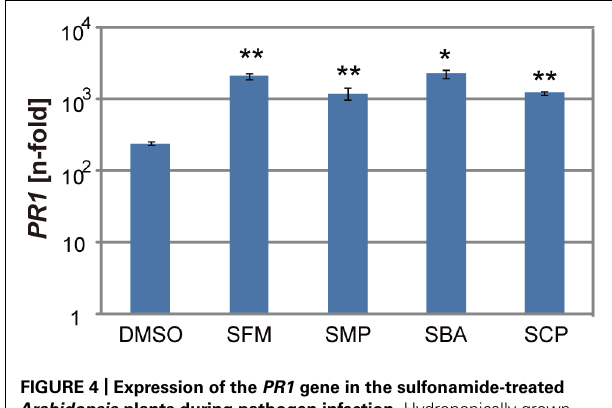
FIGURE 4 | Expression of the PR1 gene in the sulfonamide-treated Arabidopsis plants during pathogen infection. Hydroponically grown Arabidopsis seedlings were drenched with water containing 100 μ M of each chemical for 3 days before inoculation of Pst-avrRpm1 with spraying. The mRNA levels of PR1 were determined by qRT-PCR with cDNA prepared from samples at 24 h after inoculation.The expression values were normalized using Actin2 as an internal standard.The data was represented as relative values to the uninoculated samples with DMSO treatment.The error bars represent mean ± SE values of three independent replicates. * P < 0.01; two-tailed Student’s t